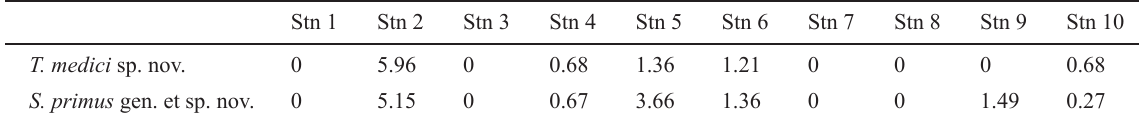
Table 5. Mean density values (ind. 10 cm -2 ) of T. medici sp. nov. and S. primus gen. et sp. nov. at the sampling stations along the Urías system recorded on 18 Jan. 2019. See also Gómez (2020a: 43, fig. 1) . Stn 1 Stn 2 Stn 3 Stn